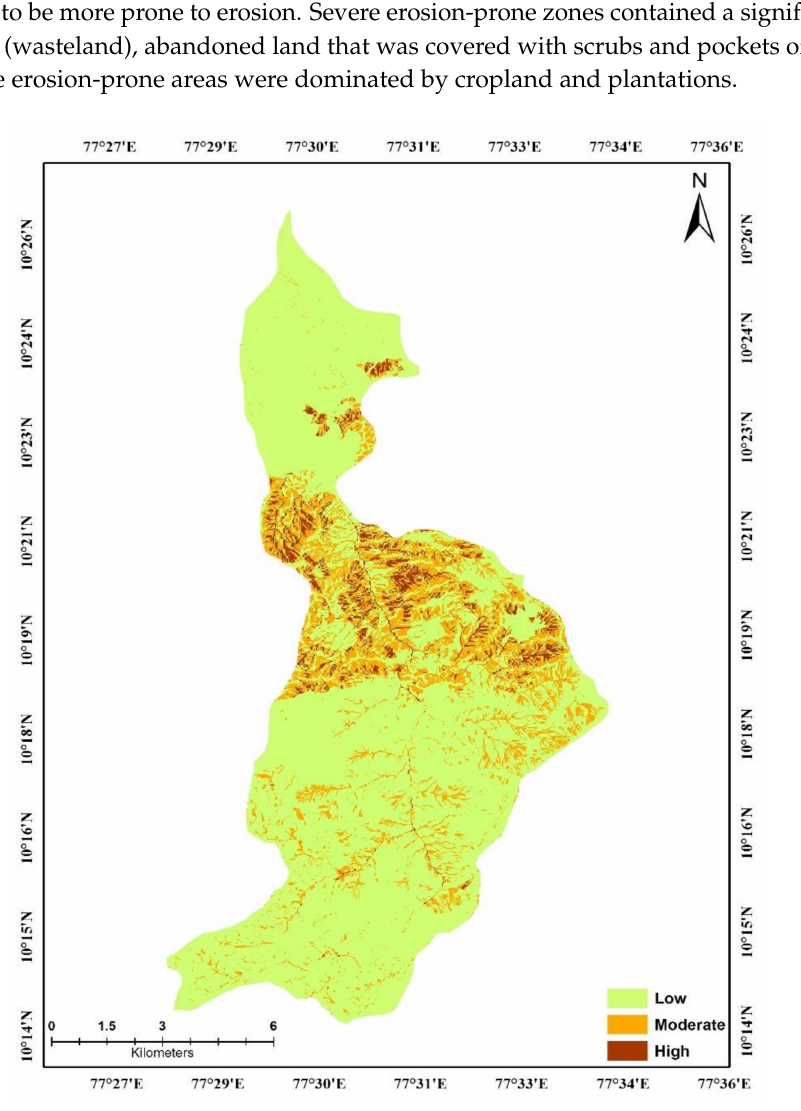
Figure 7. Spatial distribution of erosion